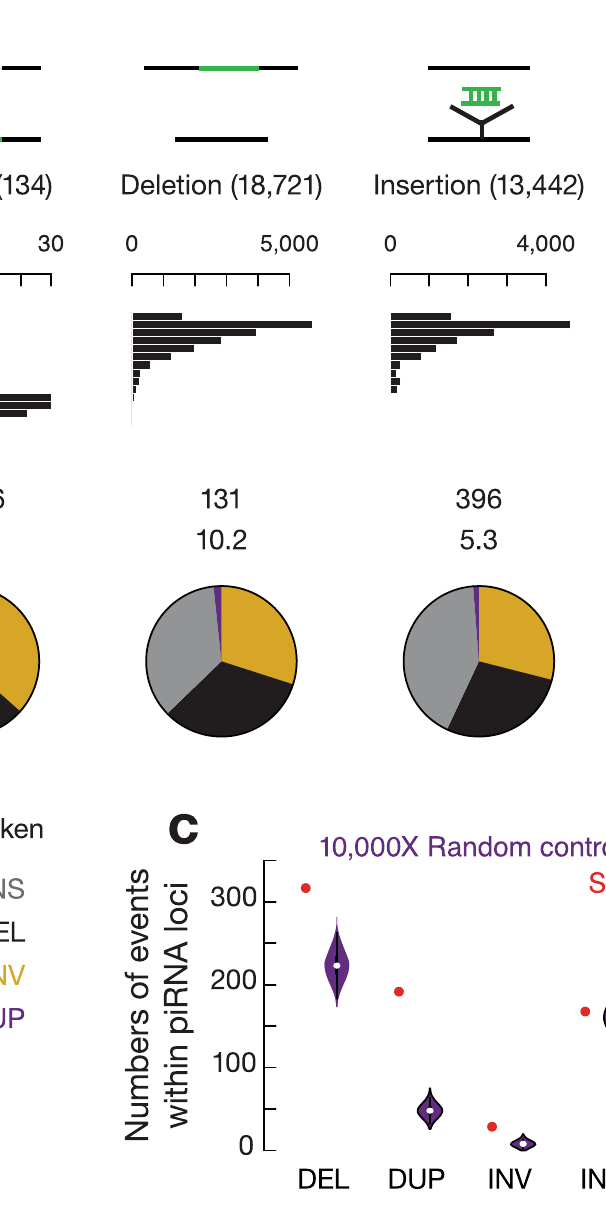
sequences that were computed 10,000 times.